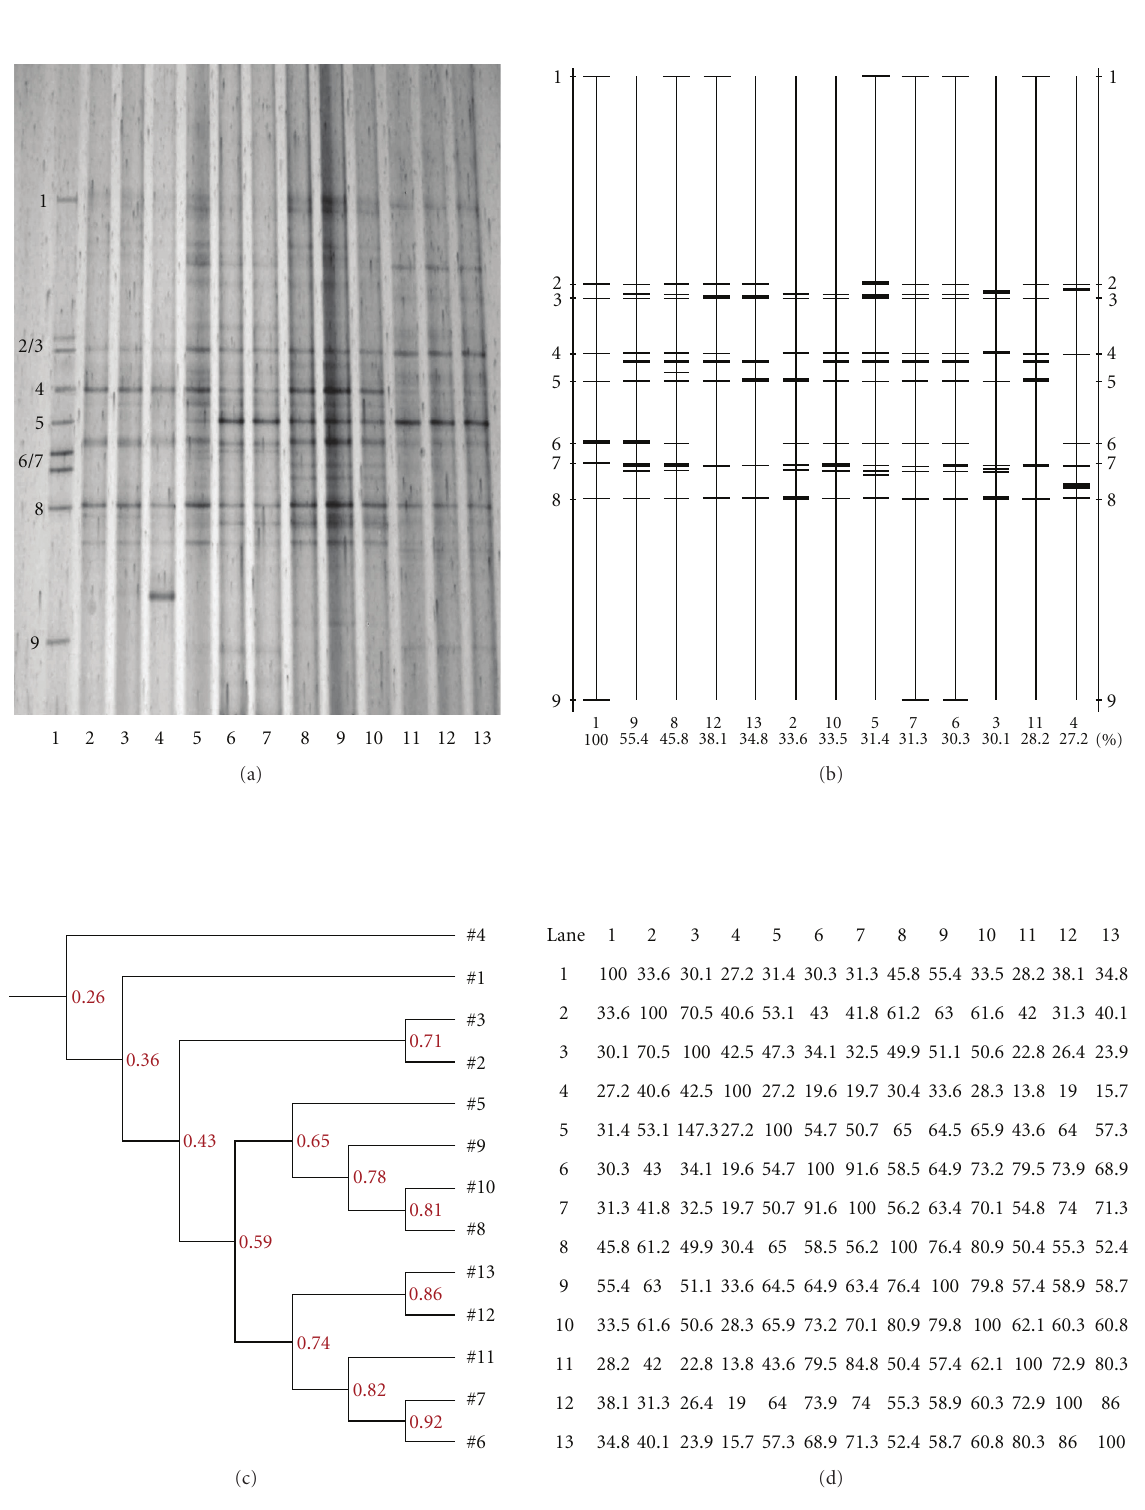
Figure 3: (a) DGGE profiles of V 3 amplicons in the cecal microbiota of weaned rats that were fed diets supplemented with 0 (2 to 4), 0.25 (5 to 7), 0.5 (8 to 10), and 1.0 (11 to 13)g/kg CYP 3 on day 7 after the initiation of supplementation. The standard strains (1) listed in order from the top of the gel to the bottom were Staphylococcus aureus , Lactobacillus amylovorus , Lactobacillus salivarius , Ruminococcus forques , Bacillus subtilis , E. coli O157 : H7, Clostridium perfringens , Salmonella typhimurium and Clostridium ituseburense, respectively. (b) Sketch map of the DGGE profiles. (c) and (d) Similarity indices of the DGGE